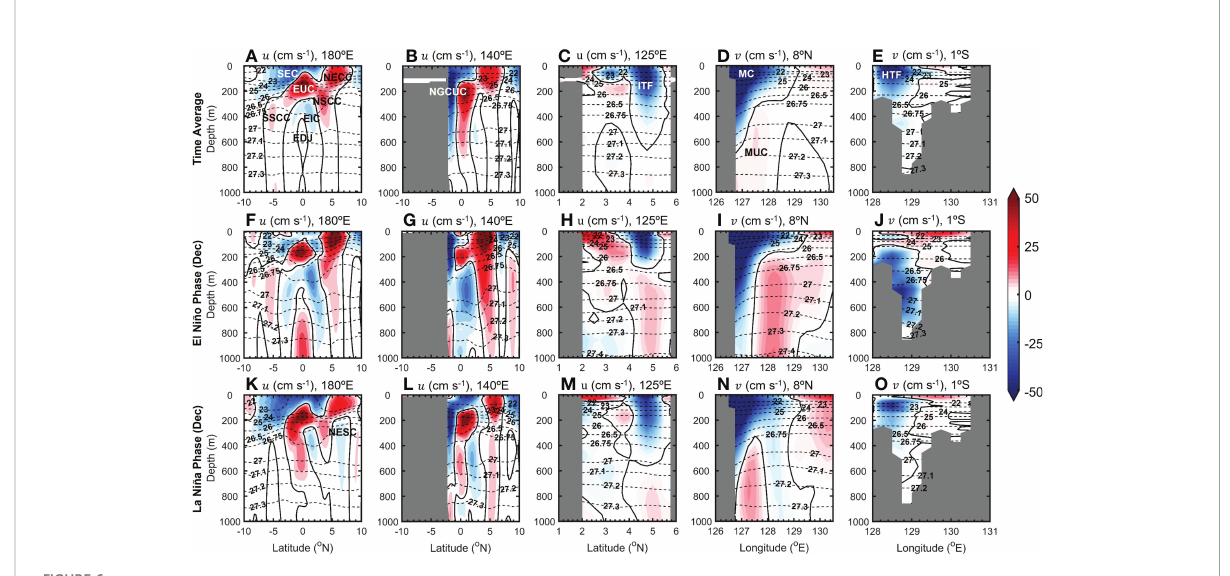
FIGURE 6 Latitude (longitude)-depth sections of zonal (meridional) velocities (cm s -1 ) from GLORYS2V4 along [ fi rst-column panels, (A, F, K) ] 180°E, [second- column panels, (B, G, L) ] 140°E, [third-column panels, (C, H, M) ] 125°E, [fourth-column panels, (D, I, N) ] 8°N, and [ fi fth-column panels, (E, J, O) ] 1ºS. The fi rst-, second-, and third-row panels are time average and composite during El Niño and La Niña phases, respectively, from January 1994 to December 2015. The black contours denote the zero velocity. The black dashed-contours denote the isopycnal layers ( sq ), which are displayed for 22, 23, 24, 25, 26, 26.5, 26.75, 27, 27.1, 27.2, 27.3, and 27.4 sq